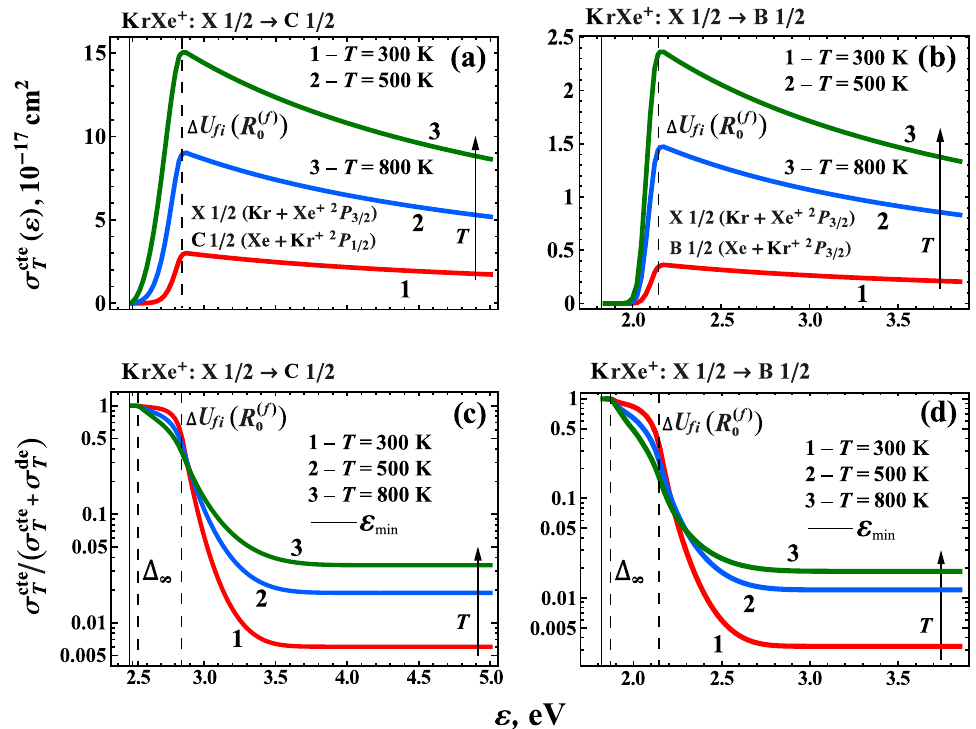
Figure 6. ( a , b ) Cross sections of the electron-impact excitation accompanied by charge exchange, σ cte in KrXe + ( X 1/2 ) + e → KrXe + ( C 1/2 ) + e → XeKr + + e ( a ) and KrXe + ( X 1/2 ) + e → T KrXe + ( B 1/2 ) + e → XeKr + + e ( b ) collisions at gas temperatures T = 300, 500, 800 K. ( c , d ) Relative ( ε ) / ( σ cte ( ε ) + σ de ( ε )) of process (2) to the total cross section of electron-impact contribution, σ cte T T T excitation of KrXe + to CT states via transitions of type A ( c ) and B ( d